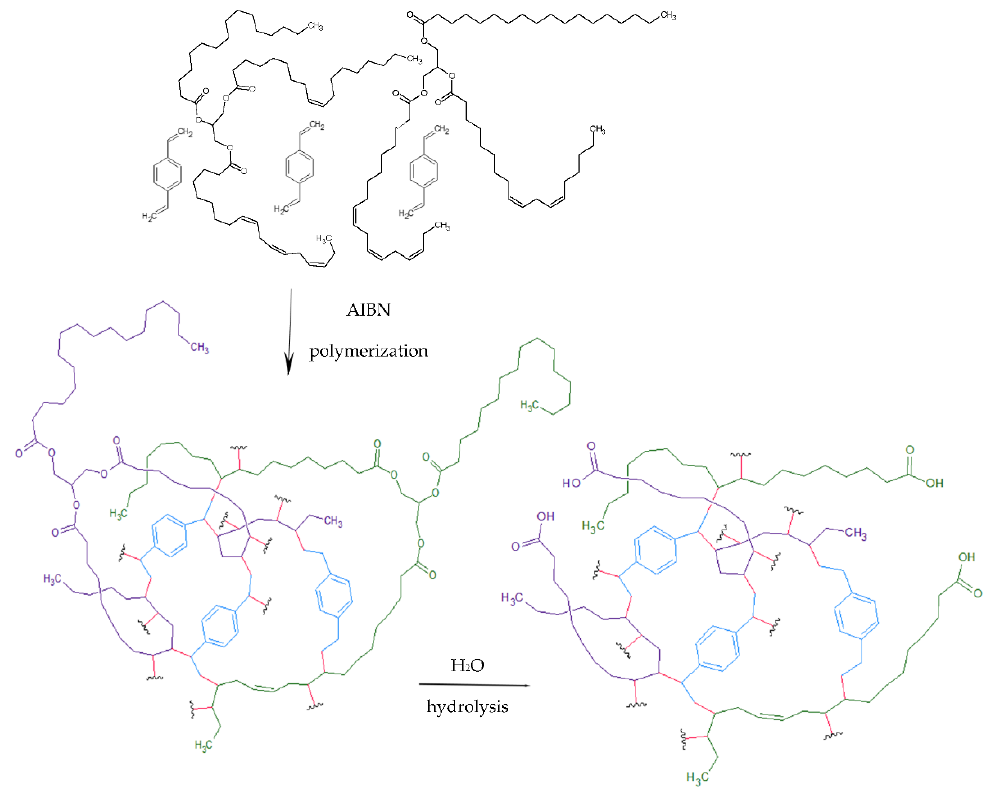
Figure 2. General scheme of polymerization of fatty esters with divinylbenzene followed by hydrol- ysis.